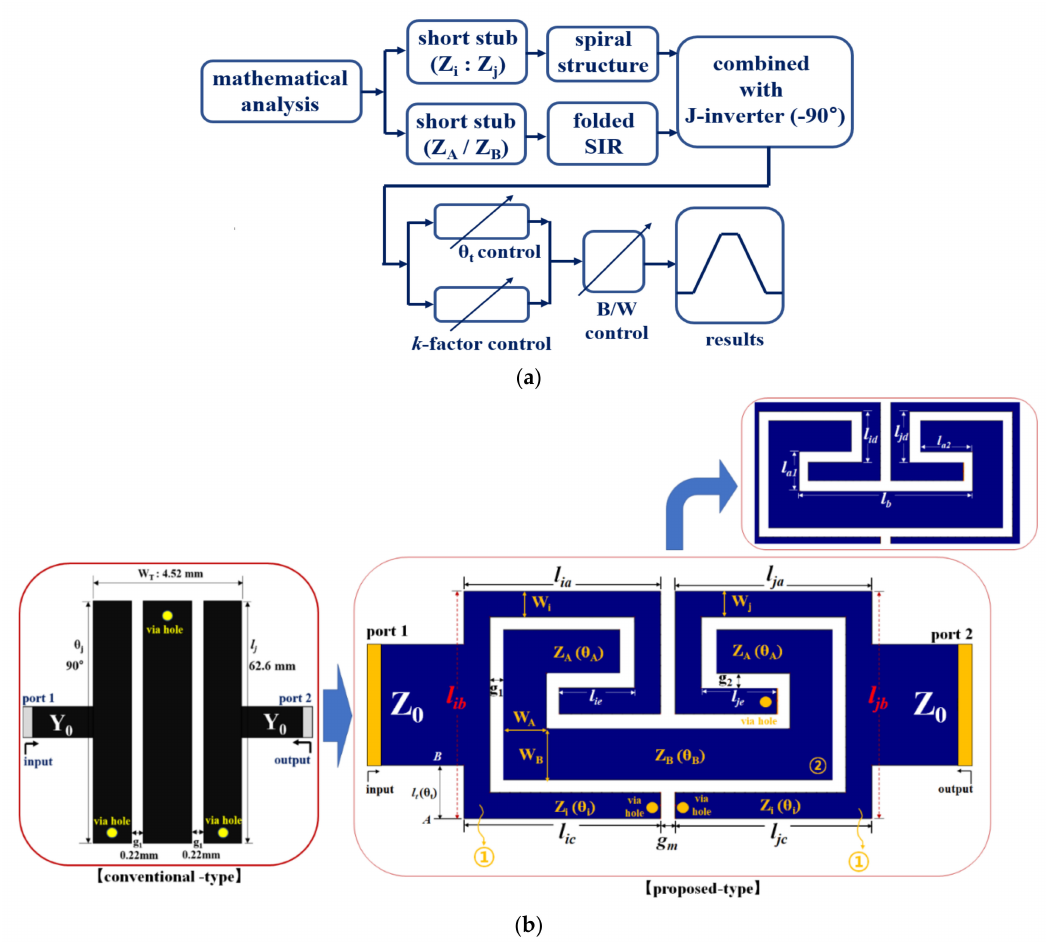
Figure 3. Structure of the proposed small − sized interdigital BPF using the spiral and SIR techniques: ( a ) flowchart (block diagram) ( b ) filter